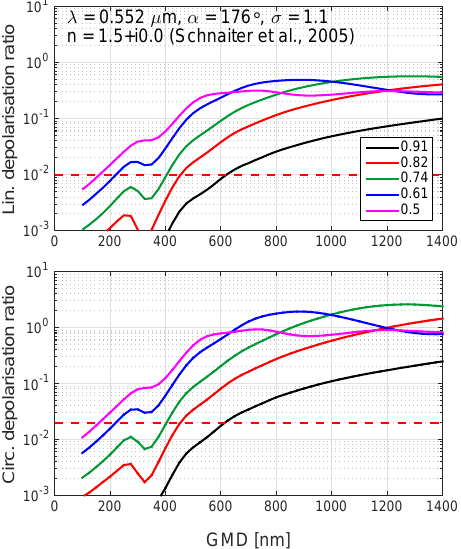
Figure 2. To plan the experiment, the expected linear and circular depolarization ratios were modelled with the T -matrix model as- suming a spheroidal shape. A narrow particle size distribution with a constant GSD of 1.1 was used in the model and the GMD of the particles was varied from 0 to 1400nm ( x axis). The calculation was made for five spheroidal shapes with aspect ratios ranging from 0.91 to 0.5. The detection thresholds of the SIMONE-Junior instrument (1% for linear depolarization and 2% for circular) are indicated as dashed red horizontal lines. The modelling study indicates that the SOA particles need to be grown past 600nm to produce a detectable depolarization ratio at aspect ratios up to 0.91.